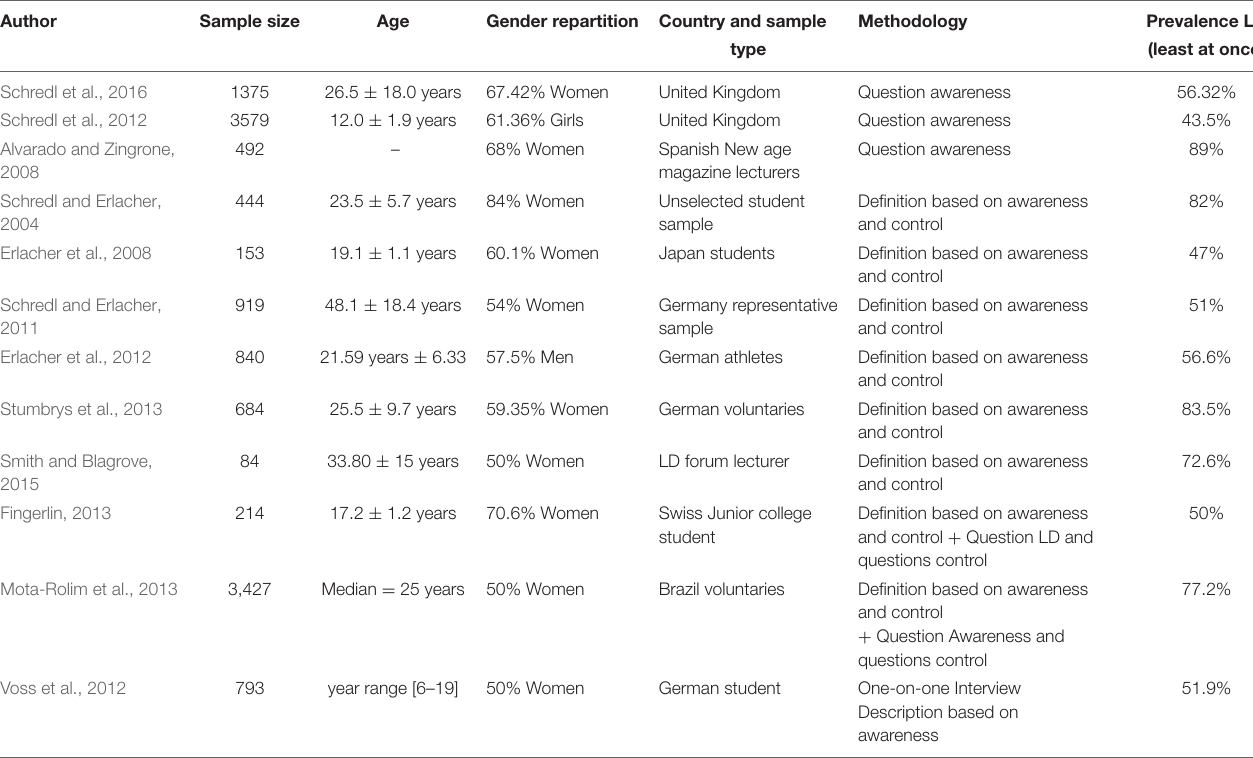
Literature search : The purpose of this table is to illustrate how LD prevalence and methodology vary across studies focusing on LD prevalence evaluation. Titles and abstracts were searched in the electronic PubMED and PsycINFO databases and in google scholar search engine (limited to the 10 first pages) using the following search terms: lucid dream ∗ /AND (frequency OR prevalence OR incidence). Only studies published after 2000 were